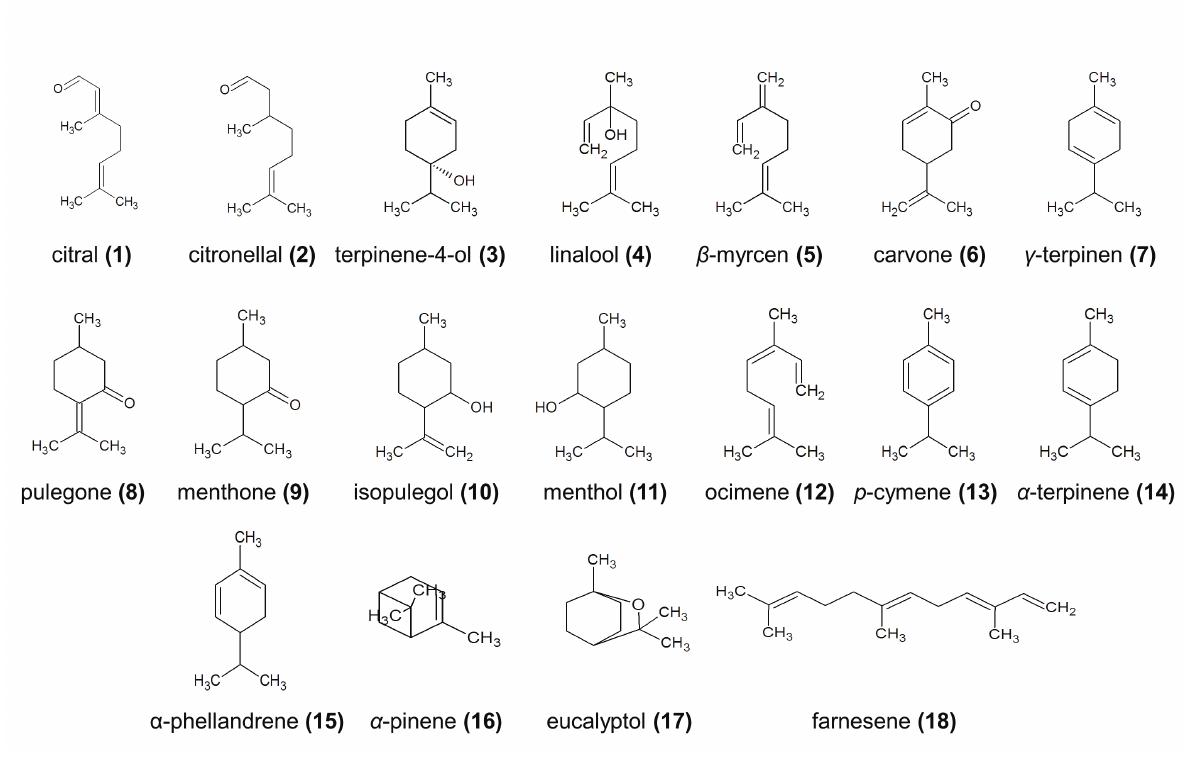
Figure 1: Structures of terpenes used in the presented